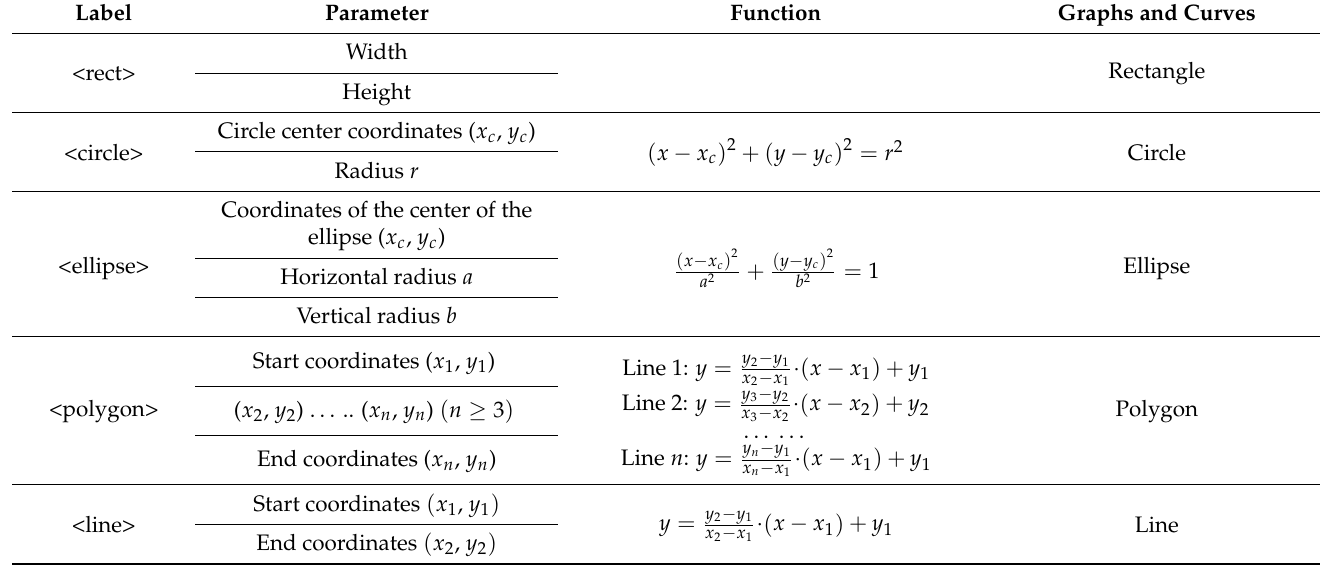
Table 1. Coding information of an SVG.